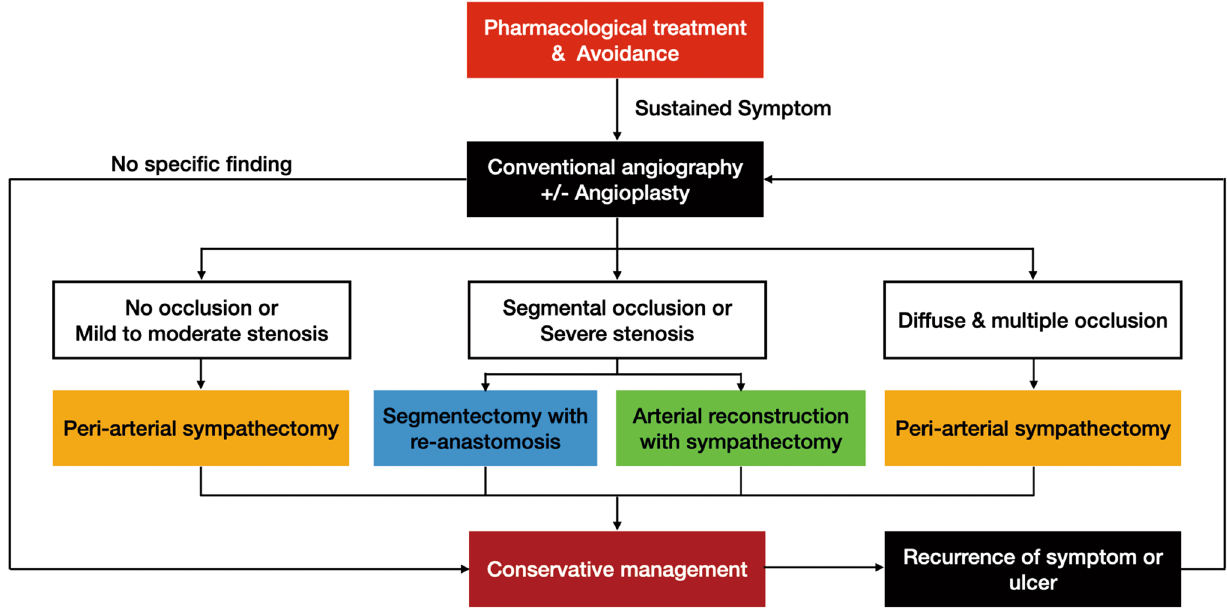
Figure 2. Algorithmic approach to surgical management of chronic hand ischemia.